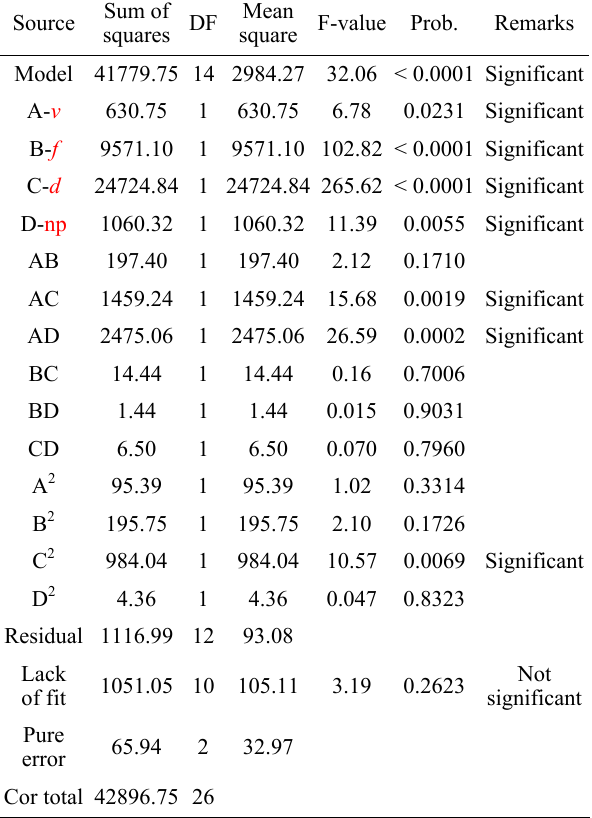
Table 3 ANOVA table of nodal temperature ( T ) for Alumina nanofluid. Sum of Mean Source DF F-value Prob. squares square